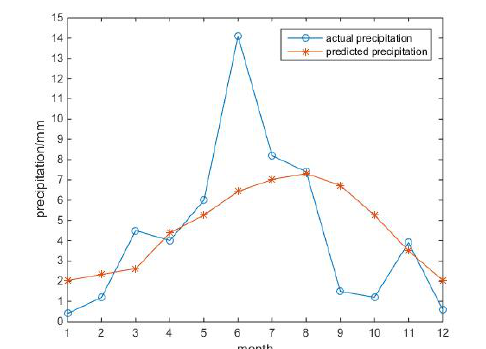
Figure 6. Figure linear regression model inter-annual prediction of precipitation changes in 2017